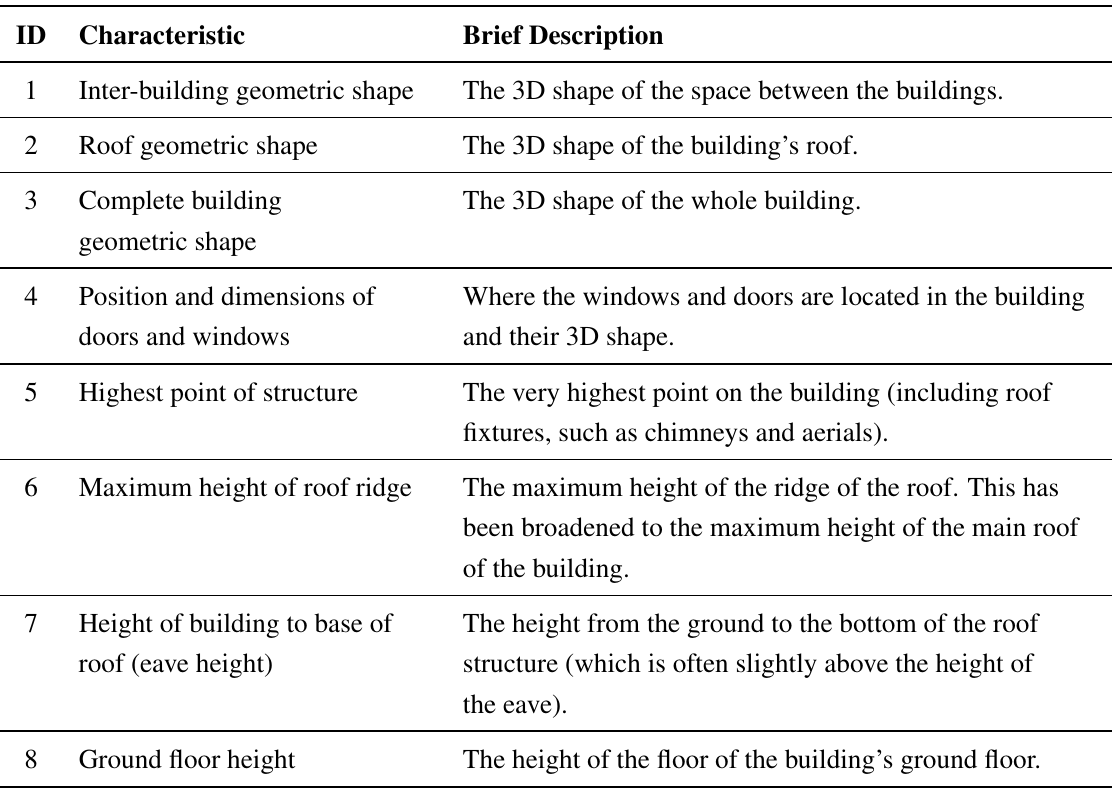
Table 1. The 8 characteristics of 3D building data that were identified as important to